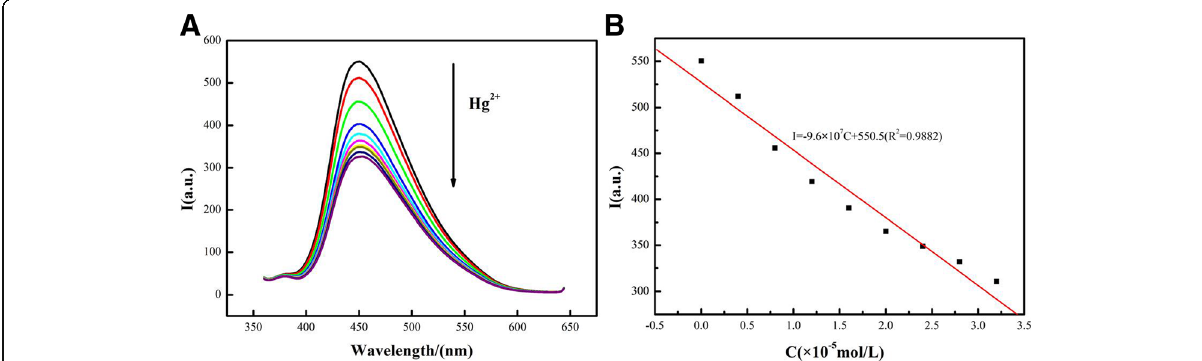
Fig. 6 The sensing properties of the CdSe QDs/g-C 3 N 4 nanosheets conjugates and the dependence of the fluorescence intensity to the concentration of Hg 2+ (C Hg2+ : 1, 0 nM; 2, 4 nM; 3, 8 nM; 4, 12 nM; 5, 16 nM; 6, 20 nM; 7, 24 nM; 8, 28 nM; 9, 32